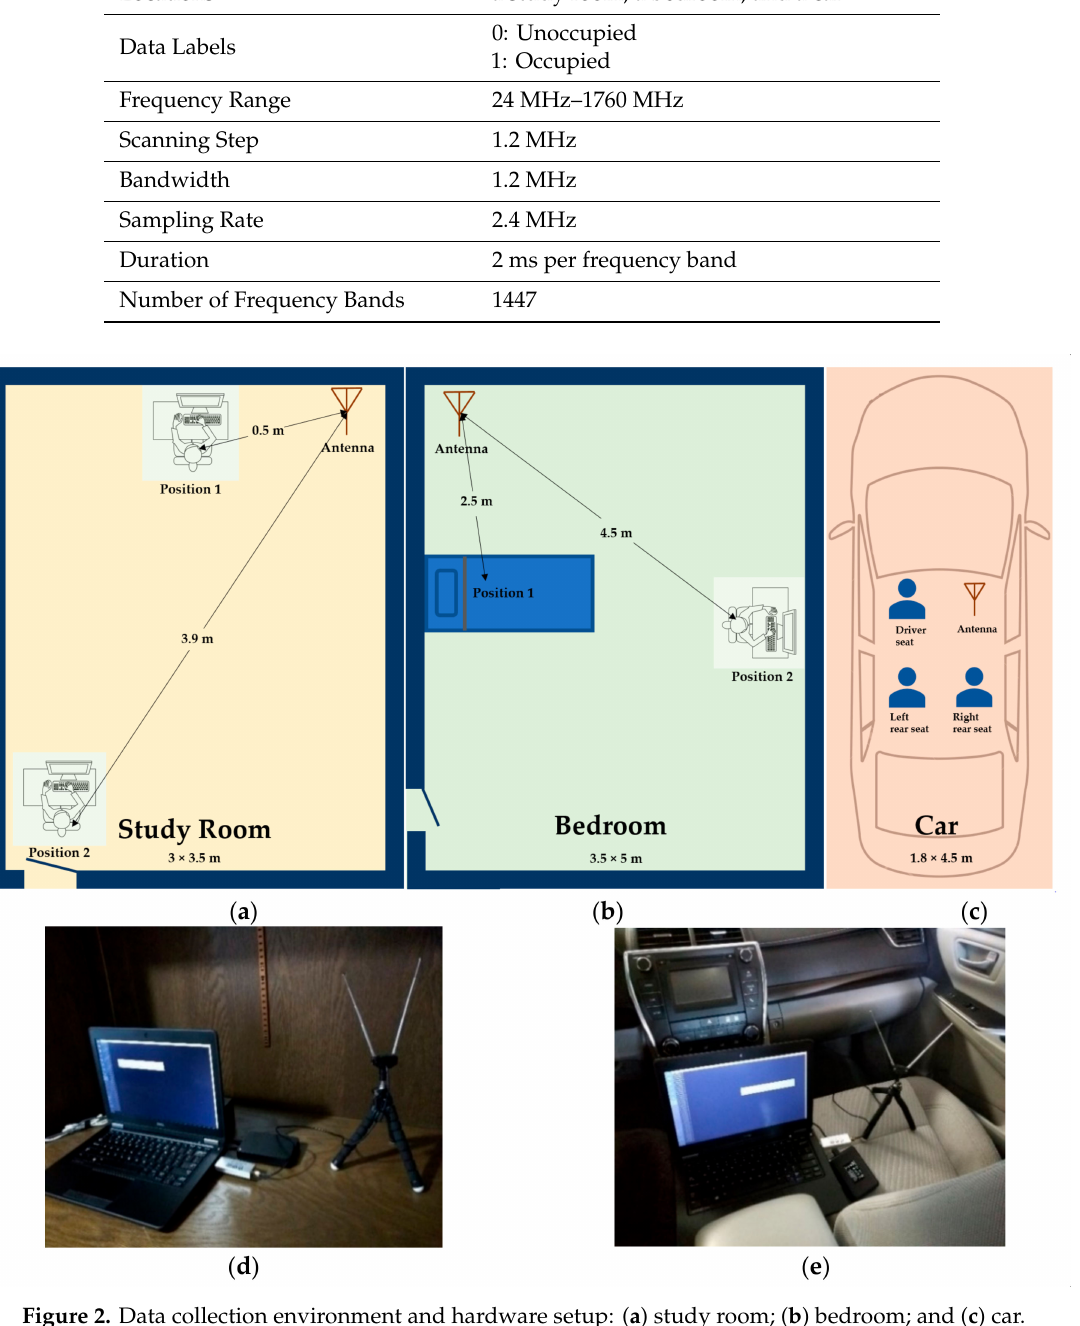
Figure 2. Data collection environment and hardware setup: ( a ) study room; ( b ) bedroom; and ( c ) car. ( d ) SDR and the antenna set up in the study room; and ( e ) SDR and antenna set up in the